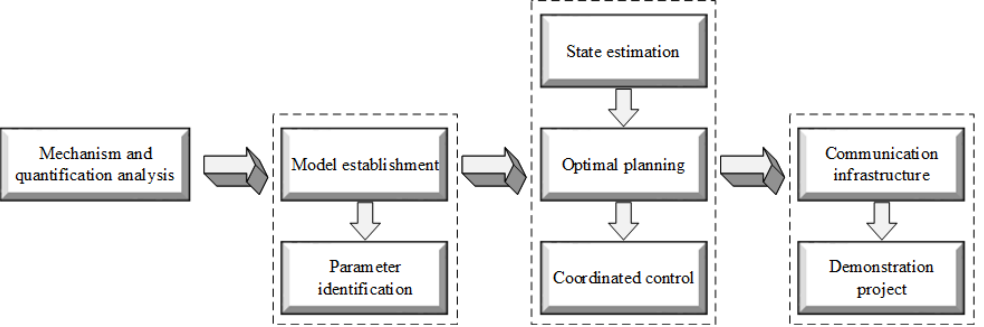
Figure 11. Suggestions for further research on the GVPP.